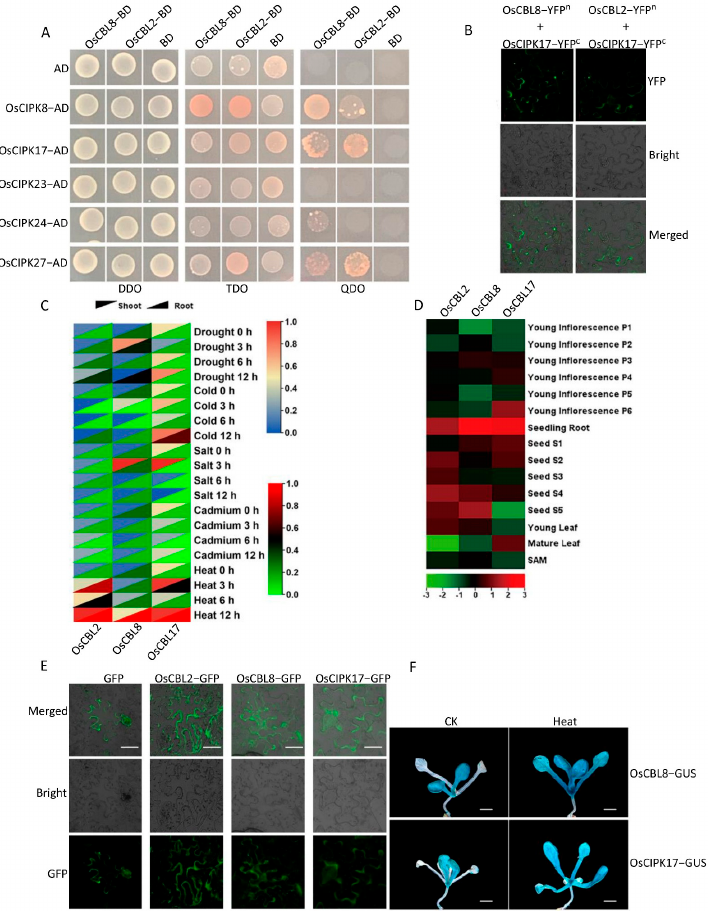
Figure 1. OsCBL and OsCIPK have specific interactions and different spatiotemporal expression patterns. ( A ) The interaction between OsCBL2, OsCBL8 and part of OsCIPK was confirmed by Y2H analysis. ( B ) The interaction between OsCBL2, OsCBL8 and OsCIPK17 was confirmed by BIFC analysis. ( C ) The heat maps of gene expression of OsCBL2 , OsCBL8 and OsCIPK17 under different stress. ( D ) The heat maps of gene expression of OsCBL2 , OsCBL8 and OsCIPK17 in different parts. ( E ) Subcellular localization of OsCBL2, OsCBL8 and OsCIPK17. Bar = 100 µ m. ( F ) Gus tissue staining of Arabidopsis transformed with the promoter regions of OsCBL8 and OsCIPK17 under high temperature stress. The scale is 100 µ m. CK, control group, without high temperature treatment; HT, experimental group, with high temperature treatment at 30 ◦ C for one